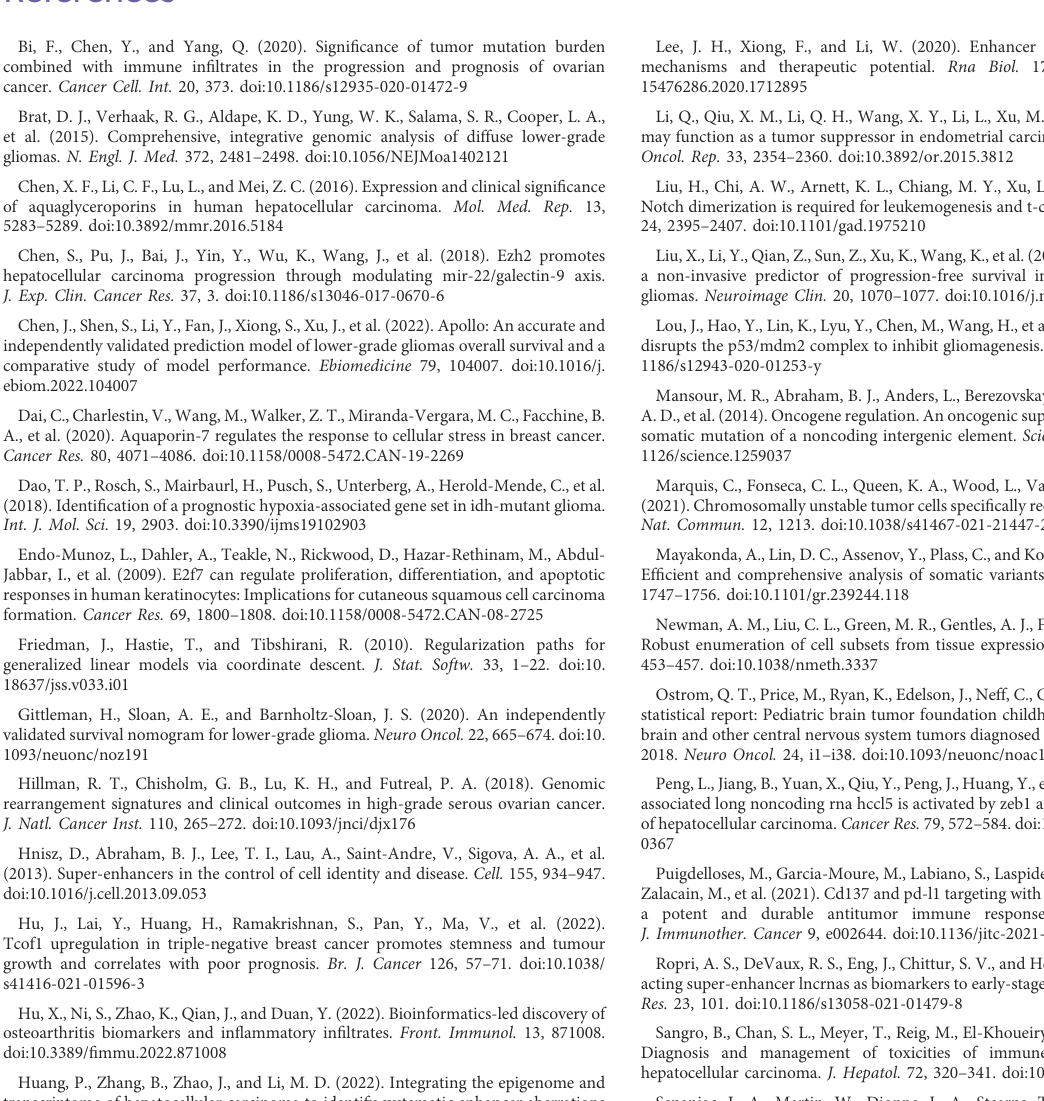
SUPPLEMENTARY FIGURE S10 The distribution of TMB, mutation counts, copy number burdens at focal and arm levels, immune scores, stromal scores, ESTIMATE